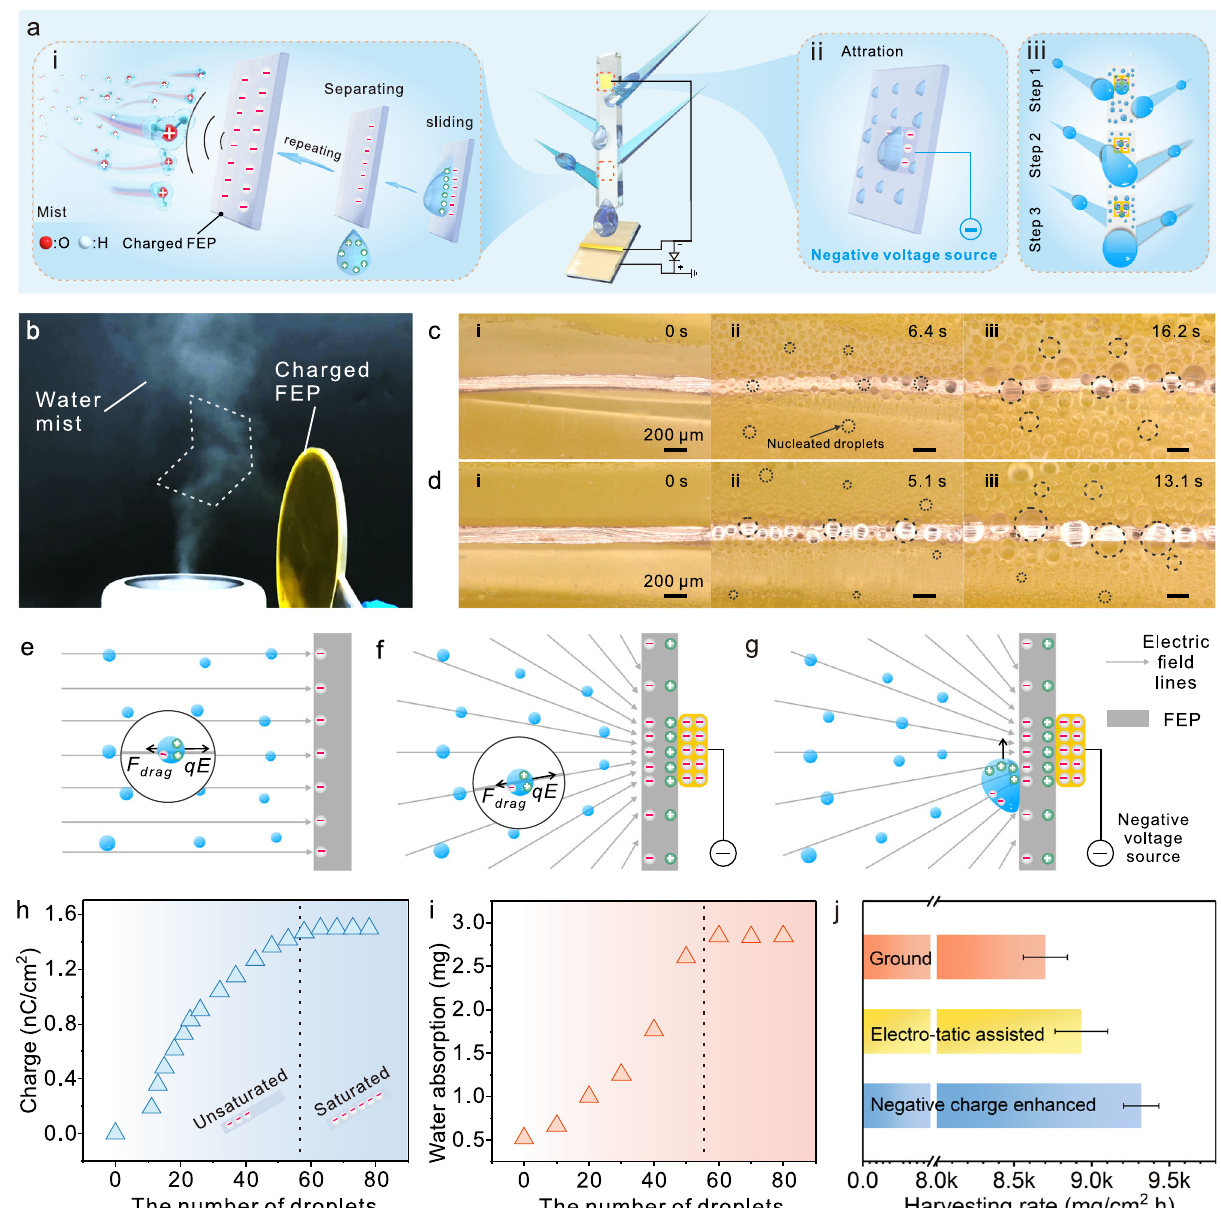
Fig. 6 Electrostatically assisted water collection. a Schematic diagram of electrostatically assisted water harvesting. Static electricity was from the triboelectri fi cation between droplets and FEP as well as external charges. b Upward moving water mist was attracted to the charged FEP wafer. A copper wire was attached to the back of the FEP, which was subsequently exposed to fog remaining uncharged c and charged d . e Schematic of droplets in an electrostatic fi eld. f , g Schematic of the droplets in the electric fi eld applied charge. h , i Charge transfer and water absorption of a thin FEP strip (5 mm × 50 mm) as water droplets slide-off. j Water-harvesting rate undergrounding, self-triboelectri fi cation, and external